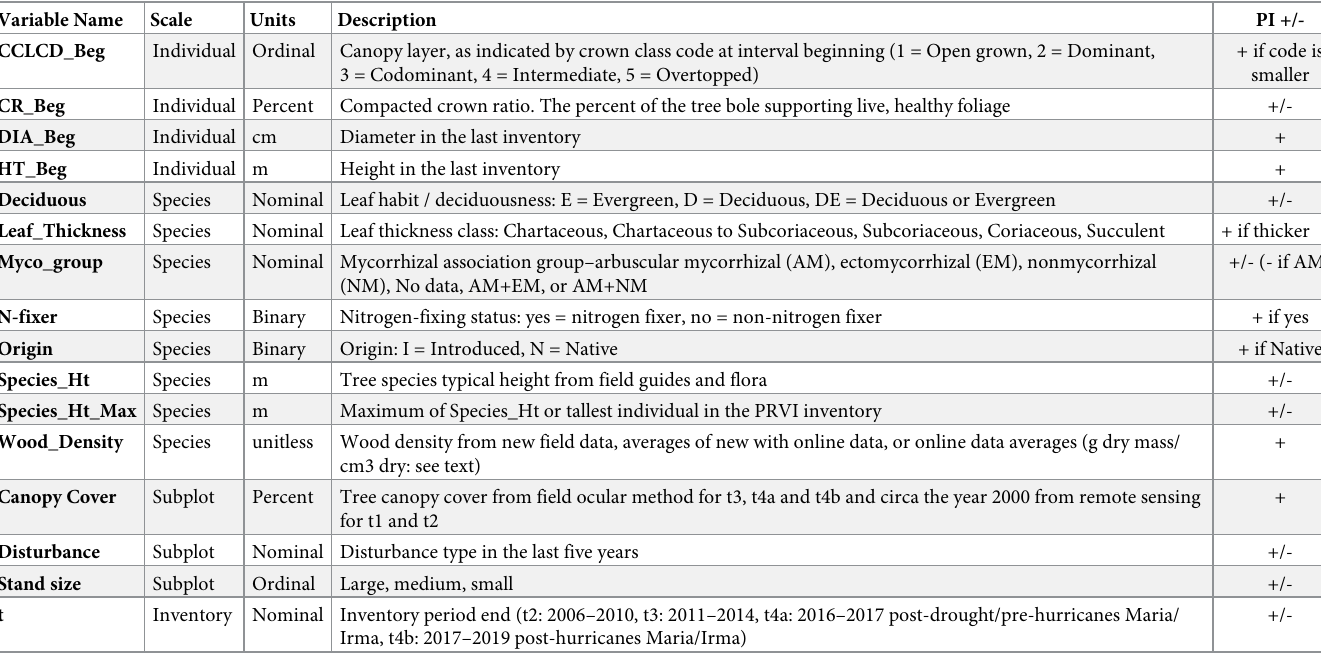
Table 1. Individual, species trait or field-collected predictors and potential influence (PI) on